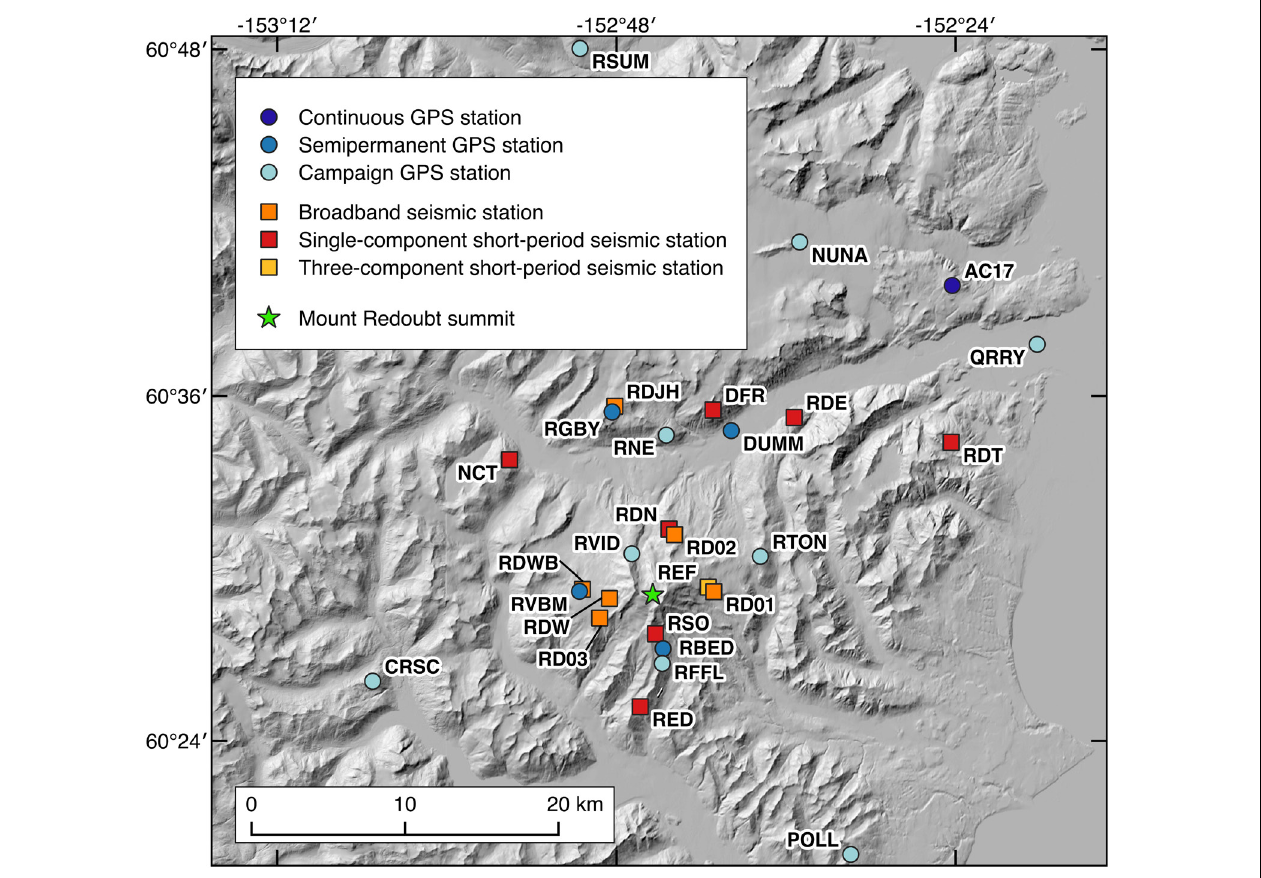
FIGURE 7 | Map showing seismic and stations at Mount Redoubt prior to the 2009 eruption. Seismic station locations are from Dixon et al. (2010) and Power et al. (2013). GPS station locations are from Grapenthin et al. (2013). See original publications for additional details. Hillshade is an ESRI Image Service product from 2013 accessed through ArcGIS